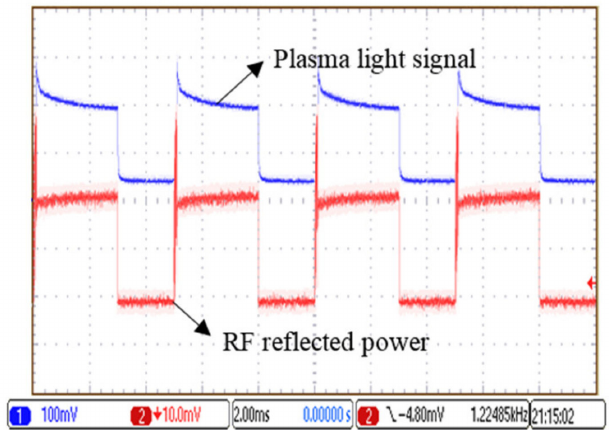
Figure 5. Variation relationship between RF reflected power and plasma light signal in glow discharge